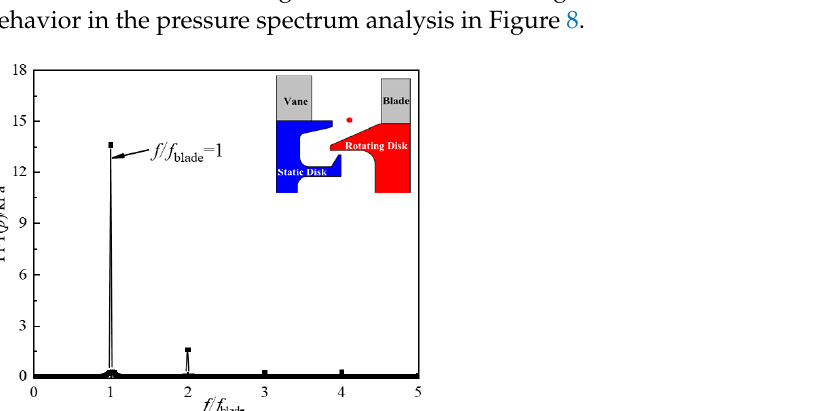
Figure 10. Transient and steady static pressure coefficient distribution along the circumferential di- rection at the clearance outlet (Seal-A and IF = 0.6%). The change in the relative positions of the vane and blades affects the pressure dis- tribution in the outlet area of the sealing clearance, which in turn affects the gas ingress and egress flow at the clearance. Figure 11 shows the pressure contours at the hub surface and the radial velocity contours at the sealing clearance exit at different times. The radial velocity directly reflects the gas ingress and egress flow at the sealing clearance. A radial velocity above zero indicates egress flow, and a radial velocity below zero indicates gas ingress. As shown in the red dotted boxes in Figure 11 at (74 + 1/2) T and (74 + 1) T , the high- pressure area between the trailing edge of the vane and the leading edge of the blade results in a large negative radial velocity area at the clearance exit. The negative radial velocity area at the sealing clearance is relatively large, and more mainstream gas intrudes into the disk cavity. At (74 + 1/4) T and (74 + 3/4) T , the radial velocity at the sealing clear- ance is influenced by the vane trailing edge flow, and the negative radial velocity is mainly distributed in the region affected by the vane trailing edge flow. Compared with (74 + 1/2) T and (74 + 1) T , the negative radial velocity region area decreases, and the area of the